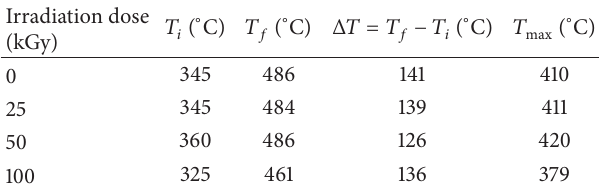
Table 2: Thermal properties of 40 wt% nHA/PA66 composites from TG and DTG